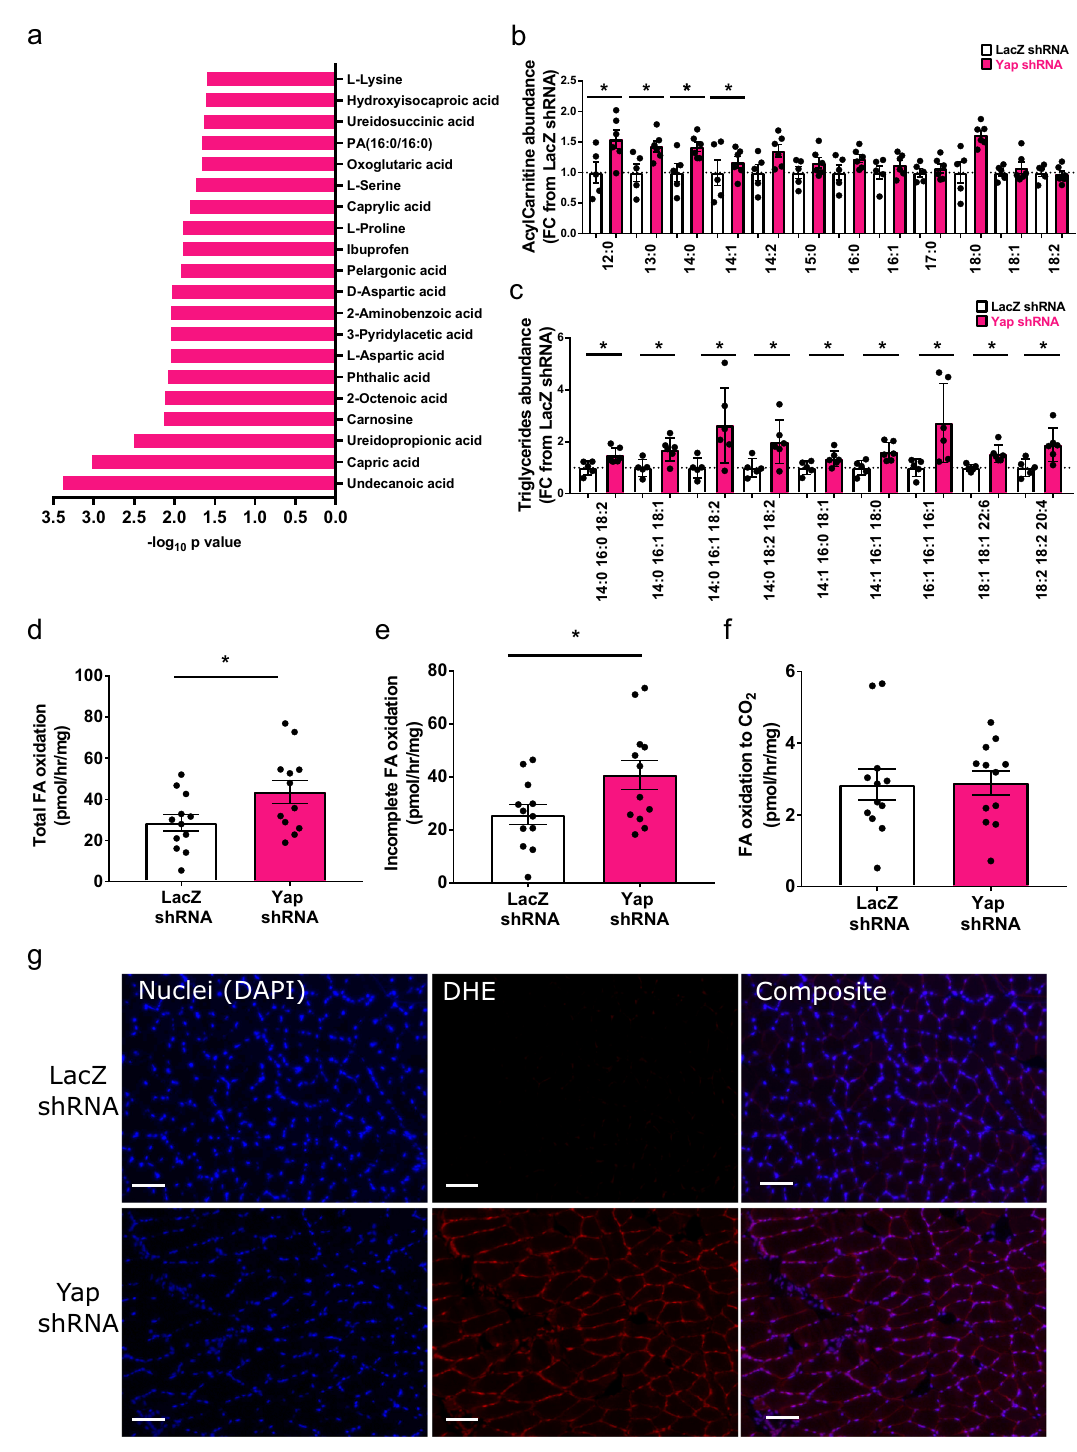
Table 1). Based on these observations, we pro fi led changes to the skeletal muscle lipidome. Muscles treated with AAV6:Yap- lacZ-shRNA to ex vivo fatty acid oxidation assays using 14 C labelled oleate. Using this approach, we were able to assess the shRNA accumulated increased quantities of long-chain acylcar- effect of modulating Yap abundance on fatty acid metabolism nitines and select triglyceride species demonstrating that sus- speci fi cally in skeletal muscles, thus mitigating potential second- tained reductions in Yap in adult skeletal muscle leads to an ary effects from other organs. The knockdown of Yap in EDL accumulation of neutral lipids and fatty acid derived- muscles increased total fatty acid oxidation rates, which were intermediates (Fig. 2b, c, Supplementary Fig. 5B, Supplementary determined to be a product of higher rates of incomplete Table 1). oxidation to β -oxidation intermediates, with no difference in the To establish the functional signi fi cance of Yap in the context of rates of complete oxidation to CO 2 (Fig. 2d – f). No differences lipid metabolism, we submitted intact EDL muscles of 8-week-old NATURE COMMUNICATIONS| (2021) 12:2887